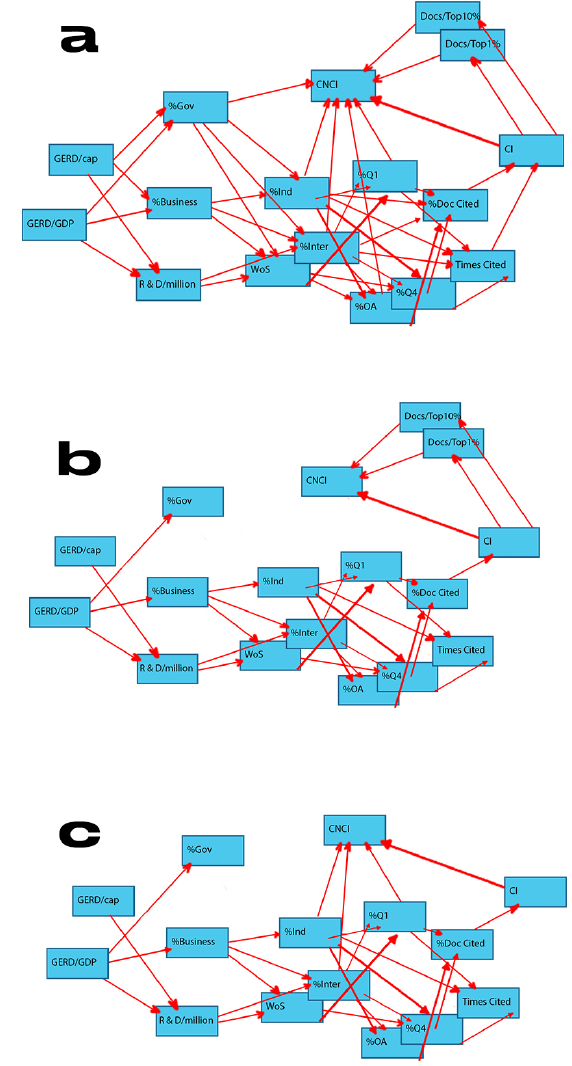
Figure 2. Hypothesised path diagrams (a) from financing (GERD/cap and GERD/GDP) to Category Normalised Citation Impact (CNCI) for all countries; Significant paths (b) Path 1 (path includes percentages of documents in Top 1% and Top 10%) and (c) Path 2 (path excludes percentages of documents in Top 1% and Top 10%). Coefficient estimates for paths are in Table SI, indicating whether the paths are significant and if coefficient effects are positive or negative. Abbreviations are in Glossary. To read the figure, start on the left-hand side (GERD/cap and GERD/ GDP). Readers can compare the hypothesised (2a) and significant (2b and 2c) paths. The lack of an arrow means that this path was not significant. Thickness of the arrow line is not relevant. For example, we hypothesised (2a) that GERD/cap would affect the % of government and % business funding in R&D (%gov); this was not significant (no line), but GERD/ cap did affect the number of researchers per million inhabitants of a country. The significant paths to the final goal (CNCI) can be followed using the arrows as a